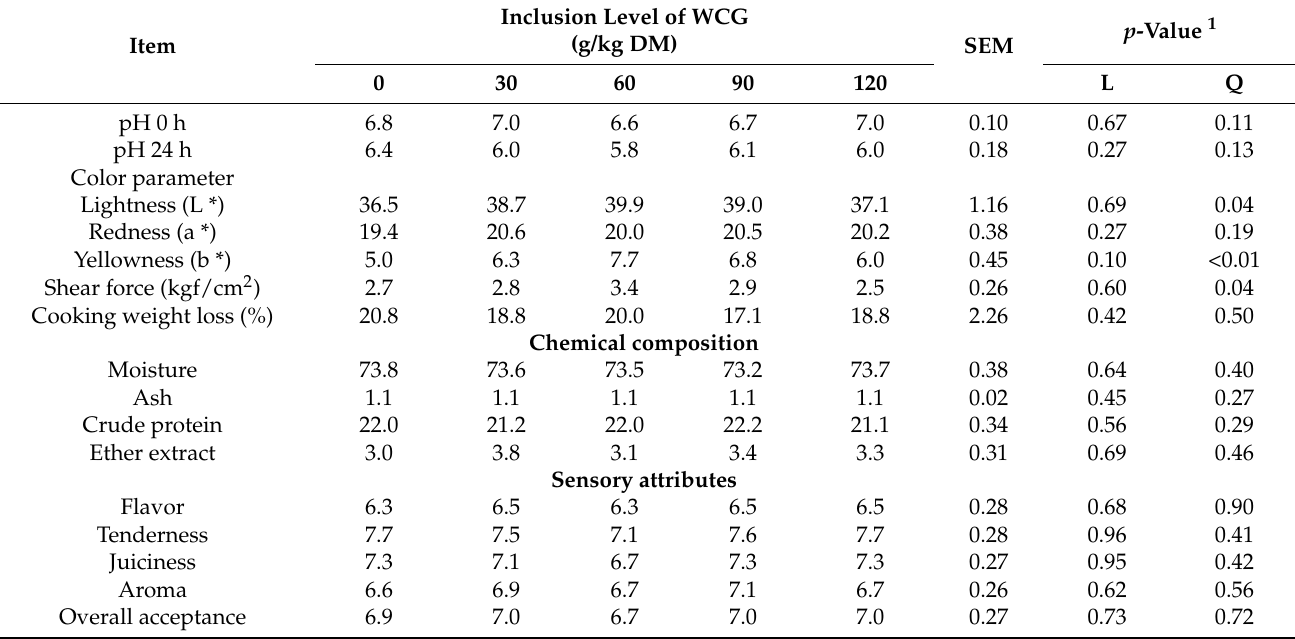
Table 3. Physicochemical composition, and sensory attributes of the Longissimus lumborum muscle of feedlot lambs fed diets with whole corn germ